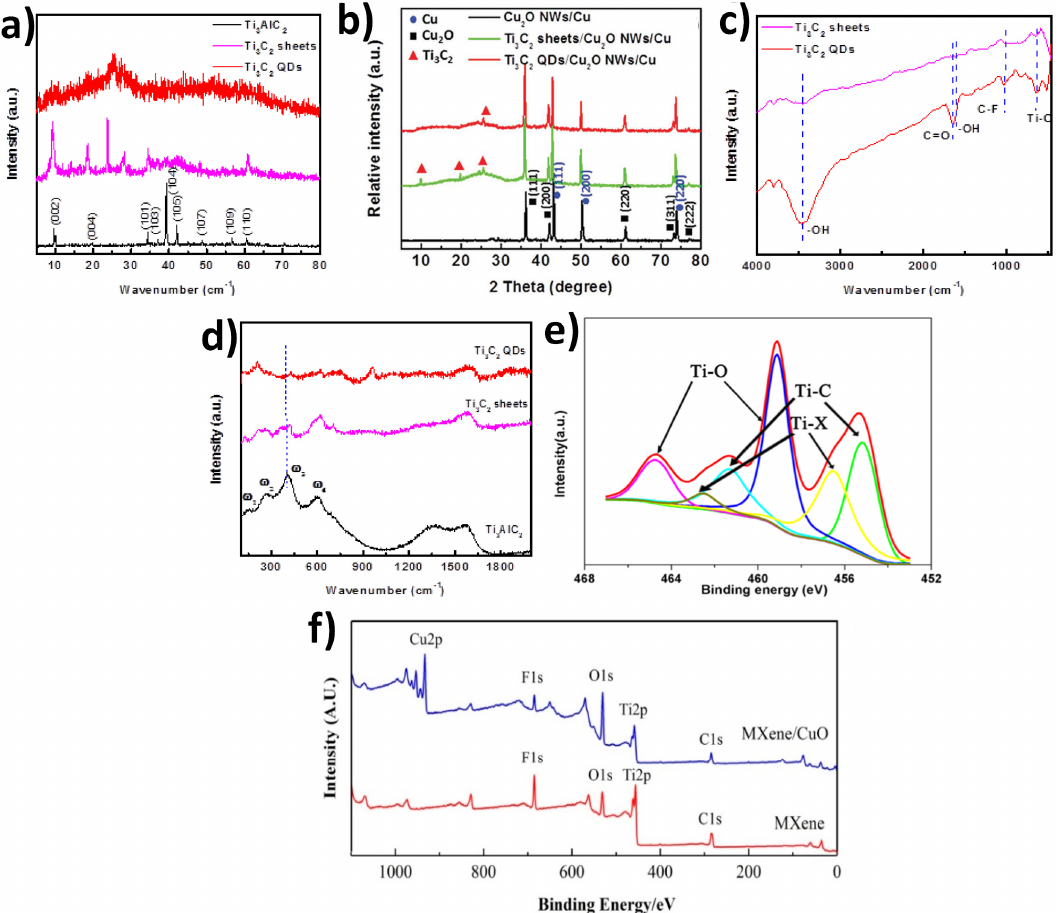
Figure 2. ( a , b ) XRD pattern of MXene sheets and QDs, MXene / CuO nanocomposite, ( c ) FTIR spectrum of MXene sheets and QDs, ( d ) Raman spectrum of MXene sheets and QDs and ( e , f ) XPS spectra of MXene with C 3 N 4 , MXene / CuO. Reprinted with permission from [48,50,52].